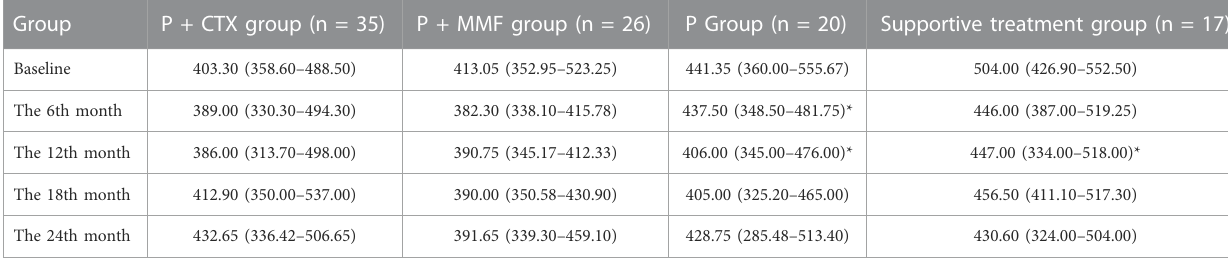
TABLE 6 Comparison of SUA in different treatment groups of severe